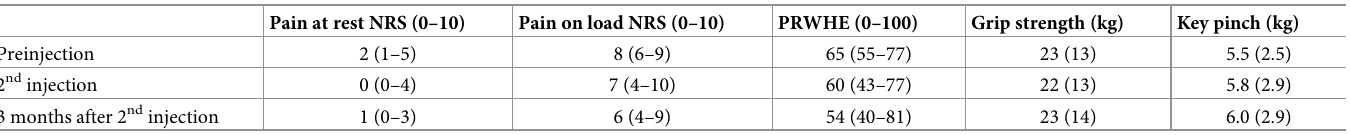
Table 2. Pain, patient-rated results and strength.